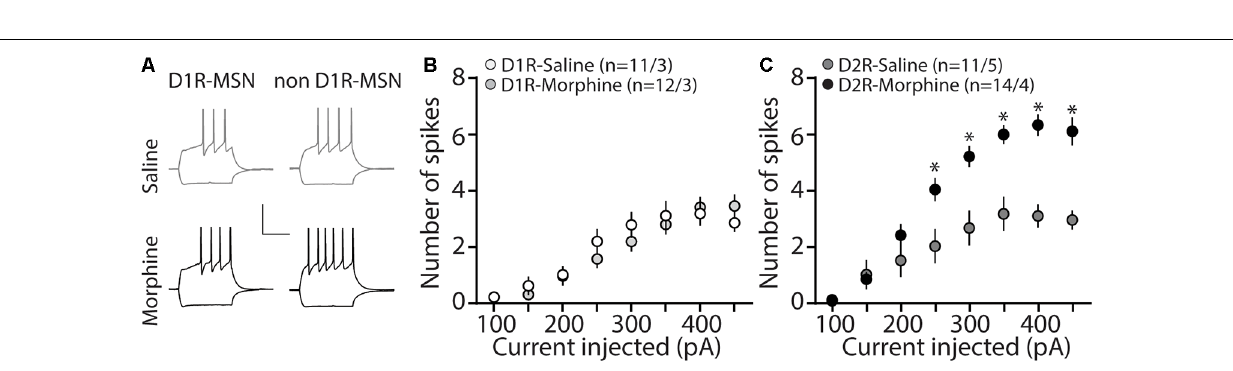
FIGURE 4 | Repeated morphine administration increases membrane excitability on D2R-MSNs on abstinence day 1. (A) Representative traces, scale bar, 40 mV, 300 ms at 100 pA current injection. (B) Summary graph showing the average number spikes generated by injected current on D1R-MSNs following saline or morphine (10 mg/kg, i.p.) treatment ( F ( 7,238 ) = 1.05, p = 0.395; two-way repeated-measures ANOVA). (C) Summary graph showing the average number of spikes generated by the injected current on D2R-MSNs following saline or morphine treatment ( F ( 7,210 ) = 10.4, p = 0 < 0.0001; two-way repeated-measures ANOVA with Bonferroni post-test). ∗ p < 0.05. (n/n =